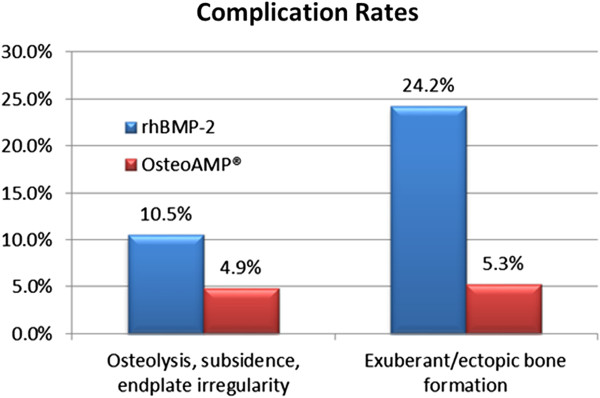
Complication rates.